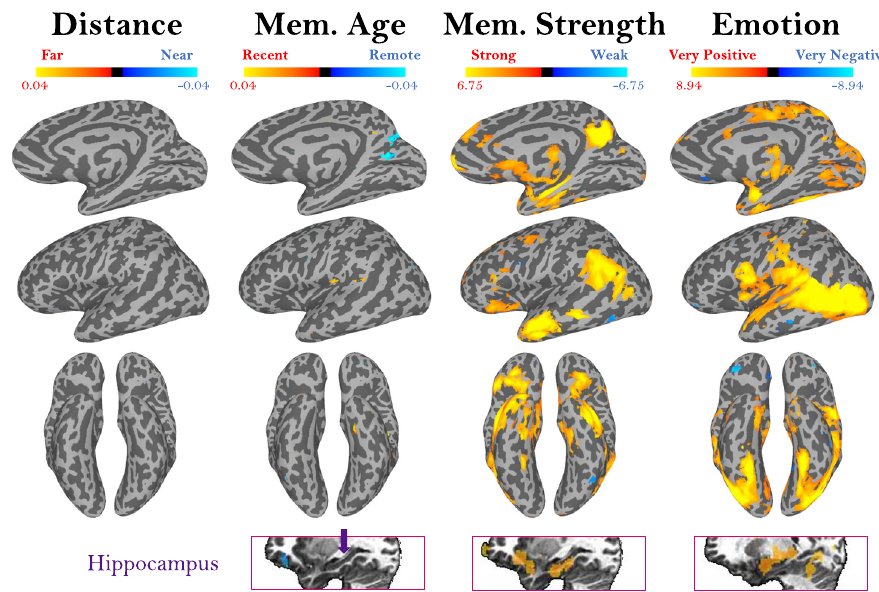
Fig. 6 | Representations of different memory content. Maps show whole-brain results from a multiple regression predicting voxel beta values from separate predictors for a memory ’ s distance, age, strength, and emotion. Activation repre- sents the mean regressor slope ( β ) for each predictor, where signi fi cance was assessed by comparing the slope across all participants with a two-sided t -test versusanullhypothesisslopeof0( p